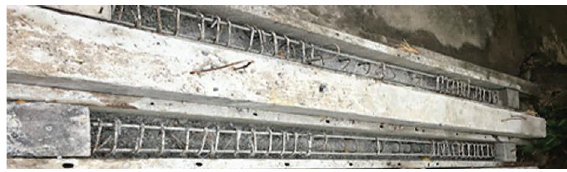
Figure 3: Te design of the formwork and the beam concrete layers.